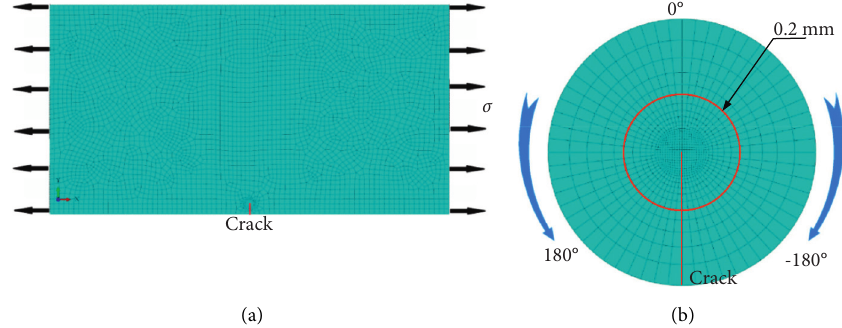
Figure 5: Mesh division of the finite element model. (a) Global model and (b) crack tip refinement